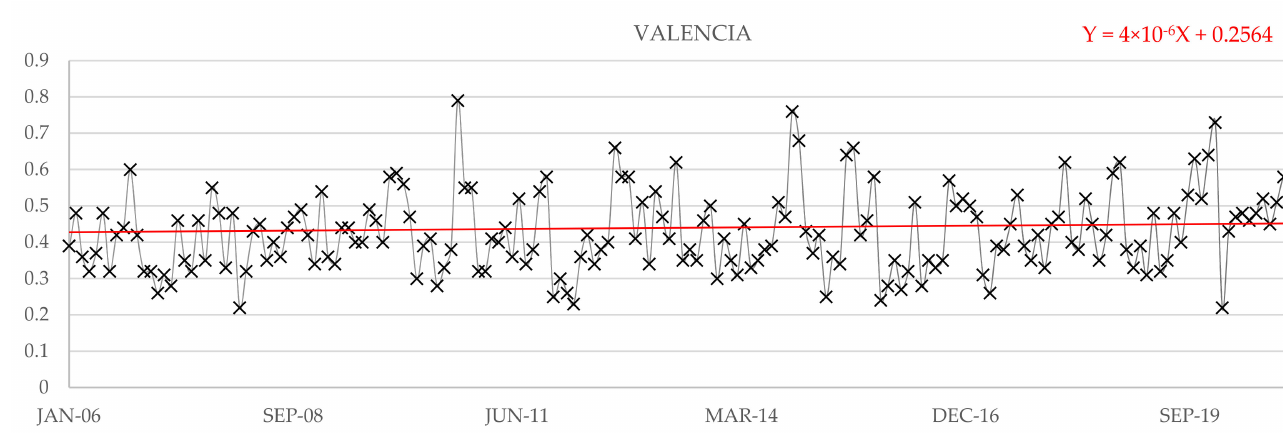
Figure 35. Evolution of SL maxima in Almeria.